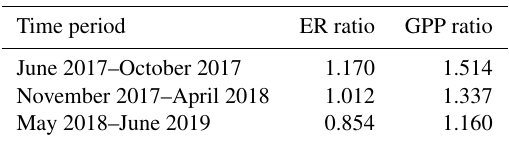
Table 3. Coefficients for scaling the chamber-based ER and GPP